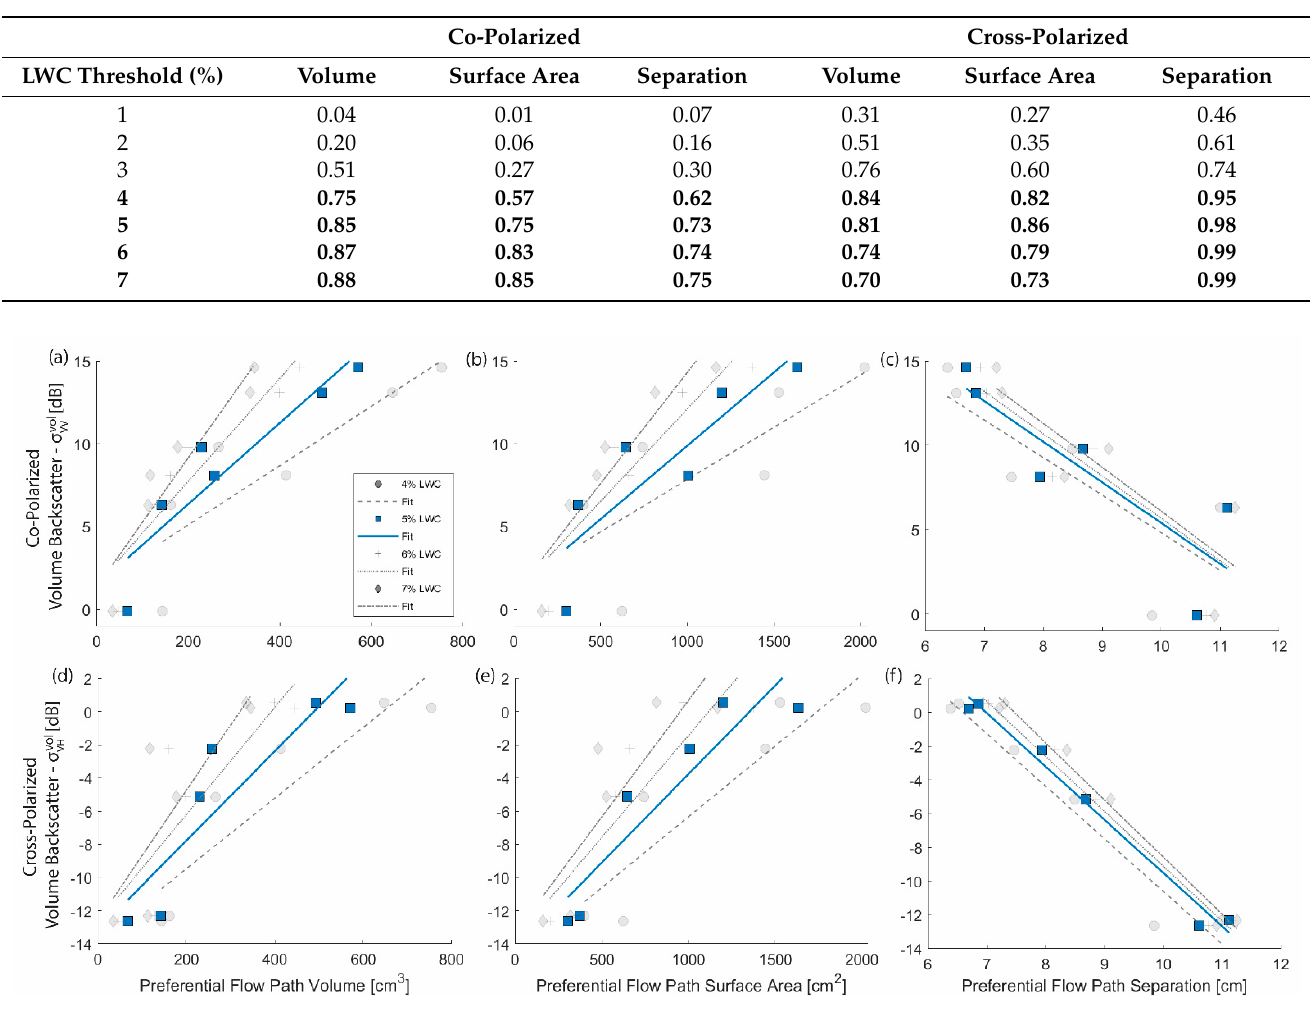
Table 3. Coefficient of determination (R-squared) between the morphology parameters at each liquid water content (LWC) threshold and the co- and cross-polarized volume component at the final timestep in the melt experiment, ( σ vol thresholds that are included in Figure 7.